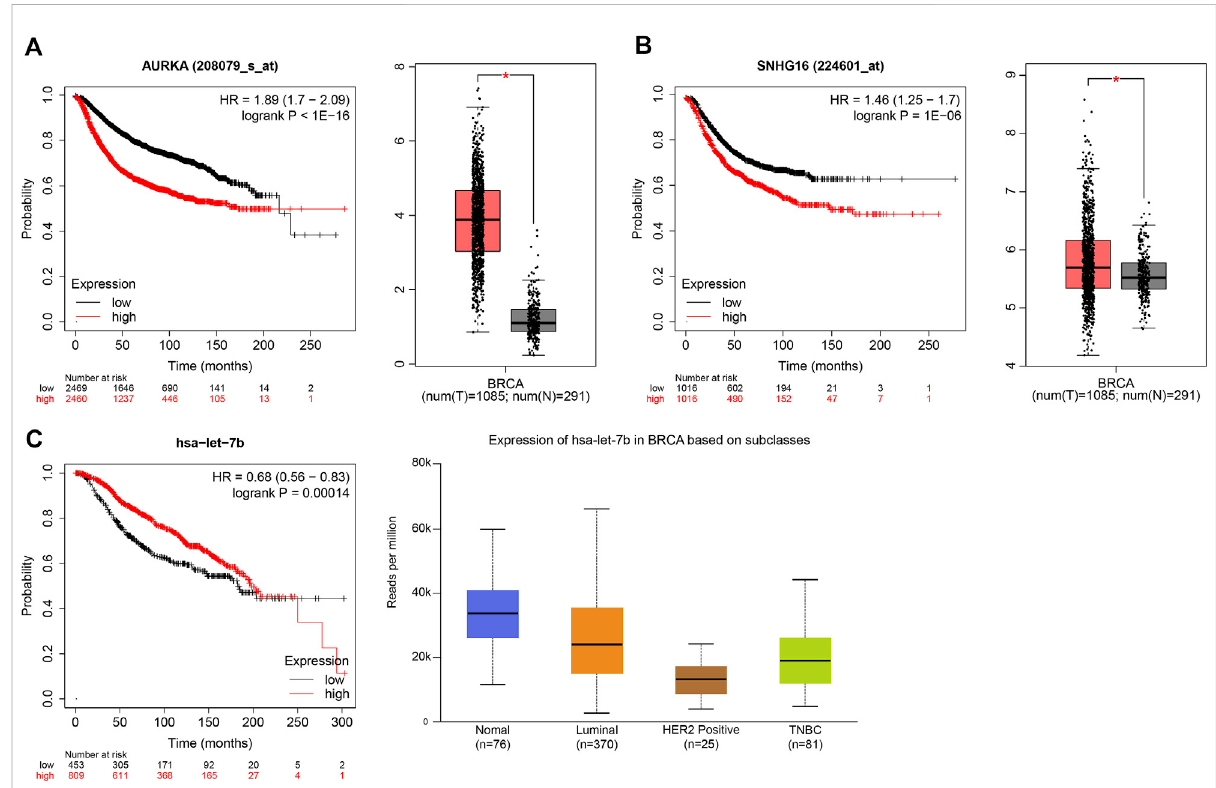
FIGURE 7 Prognosis and expression of AURKA, has-let-7b-5p and SNHG16. (A) The prognosis and expression of AURKA in Kaplan – Meier and GEPIA. (B) The prognosis and expression of SNHG16 in Kaplan – Meier and GEPIA. (C) The prognosis and expression of has-let-7b-5p in Kaplan – Meier and